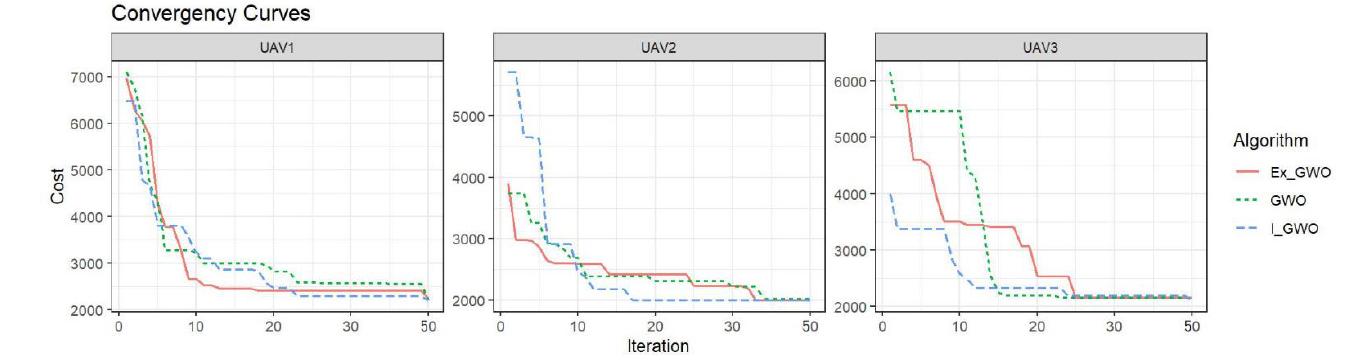
Figure 9. Convergence analysis for each UAV on the relevant map in population of 30 and 50 iterations.